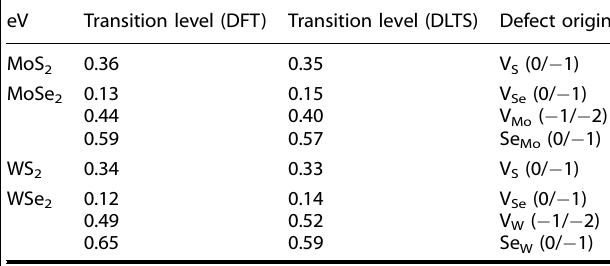
Fig. 3 Standard DLTS temperature spectra. a MoS 2 , b WS 2 , c MoSe 2 , and d WSe 2 . All the spectra were recorded with the rate window ( RW ) of 50 s-1, reverse bias ( VR ) of − 1 V, fi lling pulse ( VP ) of 0 V and the width of the fi lling pulse ( tp ) of 1 ms. The solid lines represent the individual peak contribution obtained by separated Gaussian fi tting. The obtained energy positions of the transition levels from the traps A, B, C and D in relation to CBM are also included in a – d . Table 3. Comparison between the theoretically predicted and experimentally veri fi ed charge transition levels of native point defects in bulk